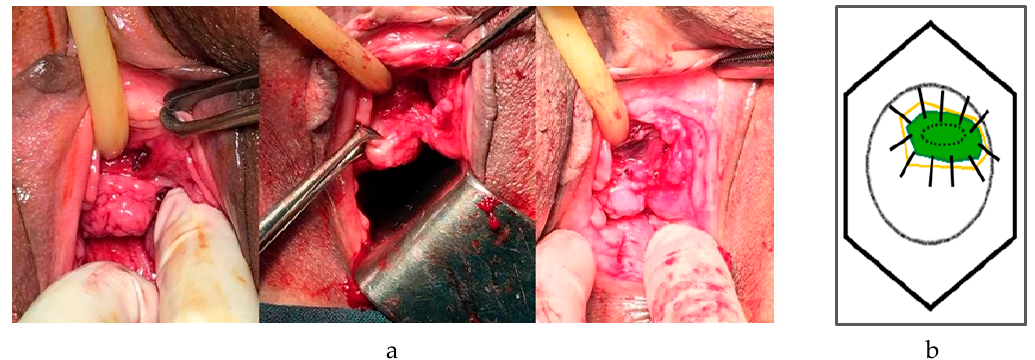
Figure 1. ( a ) Amniotic membrane used as an inlay graft. ( b ) Line diagram showing the amniotic membrane (solid orange lines) used as an inlay graft for a vaginal defect (green).